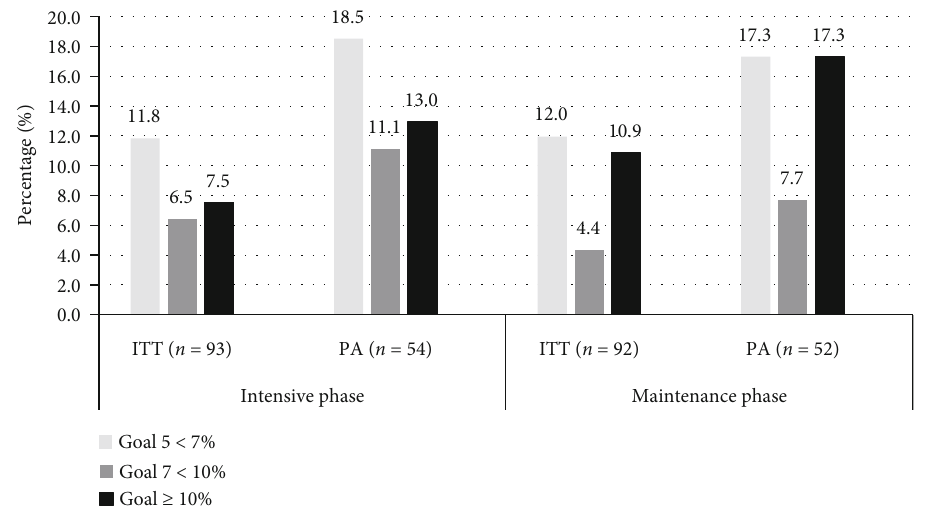
Figure 2: Goal of the loss of body weight achieved by the participants in the intensive and maintenance phase of the program. ITT: intention to treat analysis; PA: protocol analysis (completers).